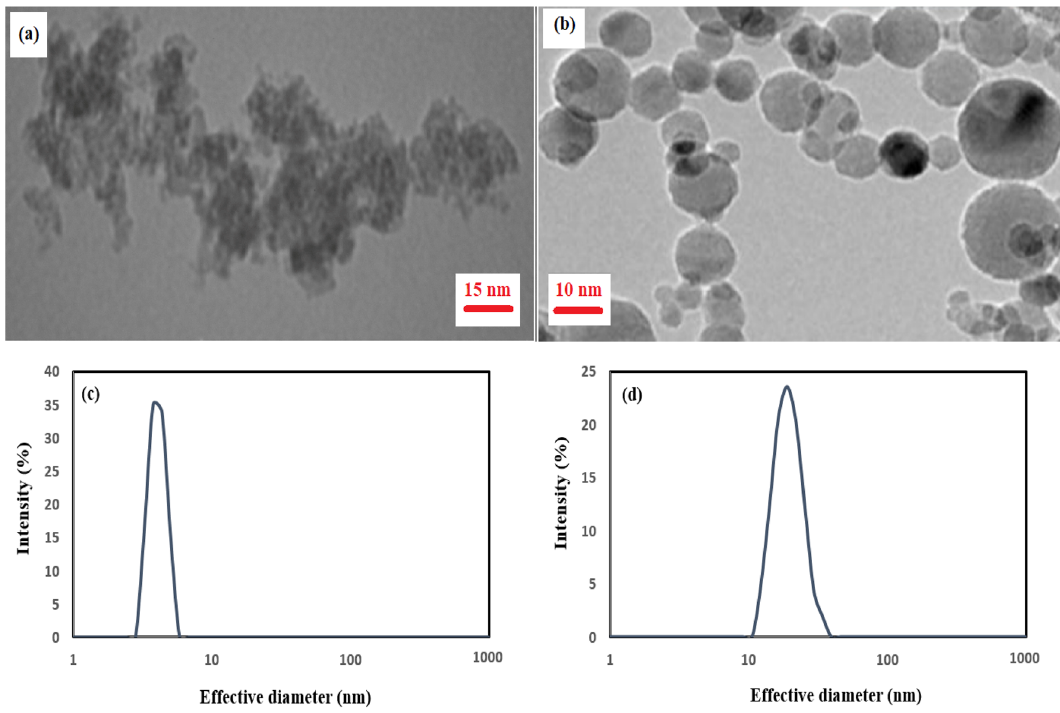
Figure 1. ( a ) TEM micrograph for α-Al 2 O 3 quantum dots (AQDs), ( b ) TEM image for γ-Al 2 O 3 nanoparticles (ANPs), ( c ) particle size distribution by DLS for α-Al 2 O 3 quantum dots, ( d ) particle size distribution by DLS for γ-Al 2 O 3